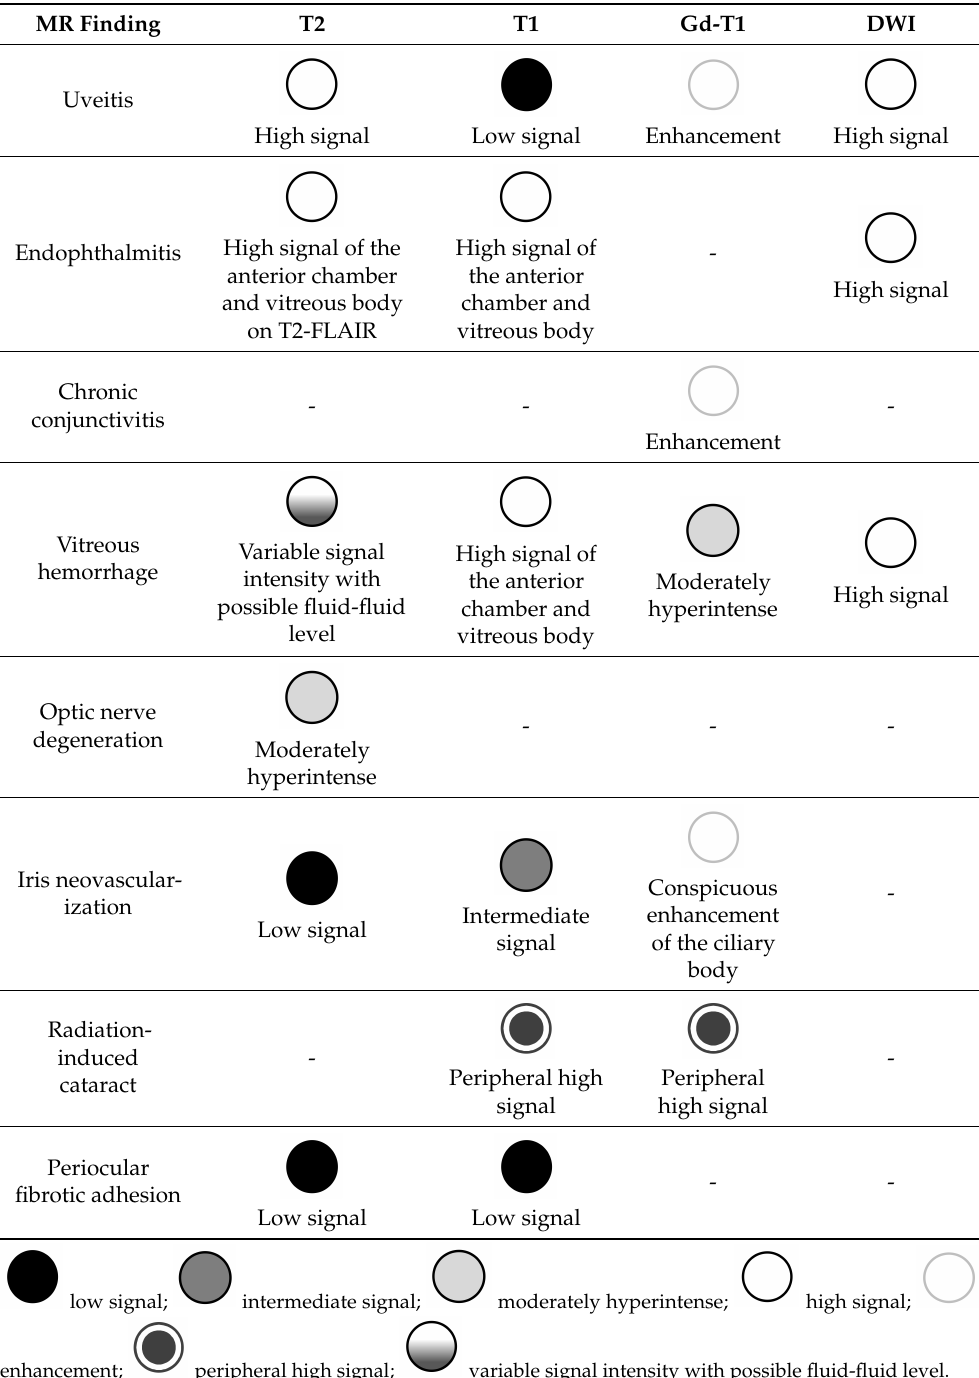
Table 6. MR imaging appearance of irradiated extratumoral ocular